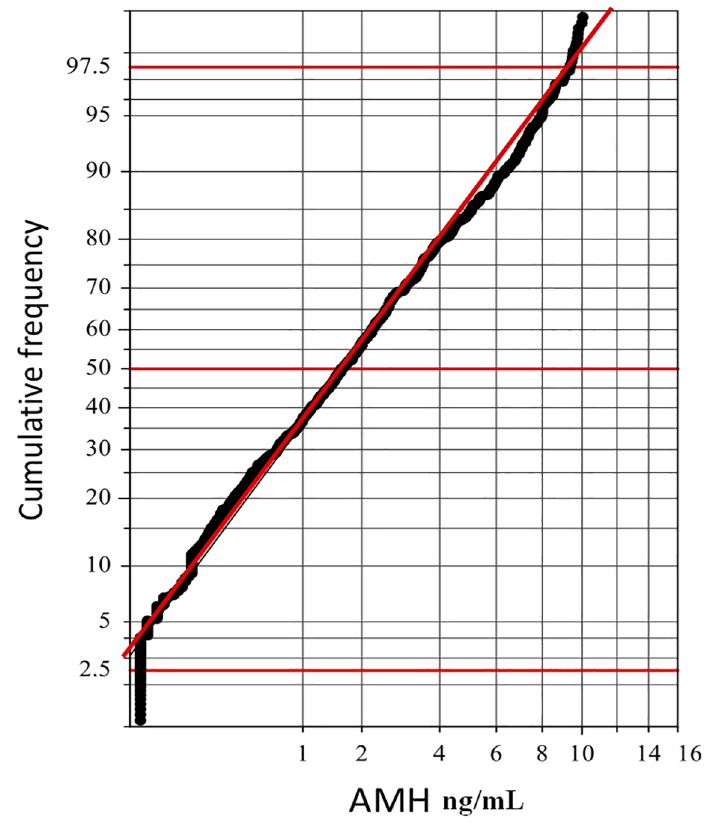
Fig 2. Confirmation of Gaussian transformation of AMH values by probability plot. The vertical axis represents the cumulative frequency (P %), transformed as log [(100 − P)/P]. The horizontal axis represents AMH test results. This axis was transformed by use of Box–Cox formula using p = 0.4 as an optimal power. The linearity of the segment between 10 and 90% indicates successful Gaussian transformation by use of the